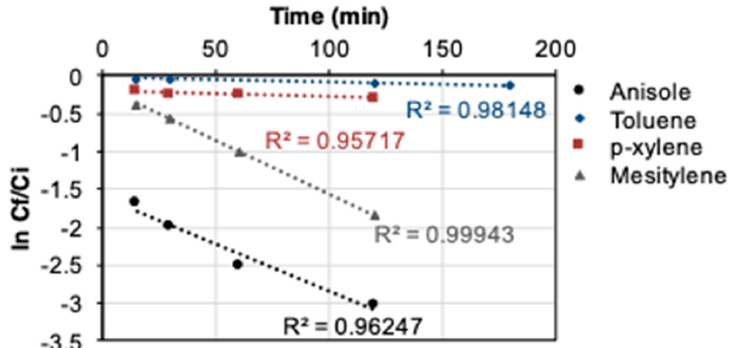
Figure 8. Langmuir-Hinshelwood pseudo-first-order kinetic model for the acylation of several aromatics over the Huntly-GP catalyst. Reaction conditions; 13 mL aromatic, 1 mL BzCl, 0.1 g catalyst; T = 130 ◦ C for all aromatics except toluene 110 ◦ C.